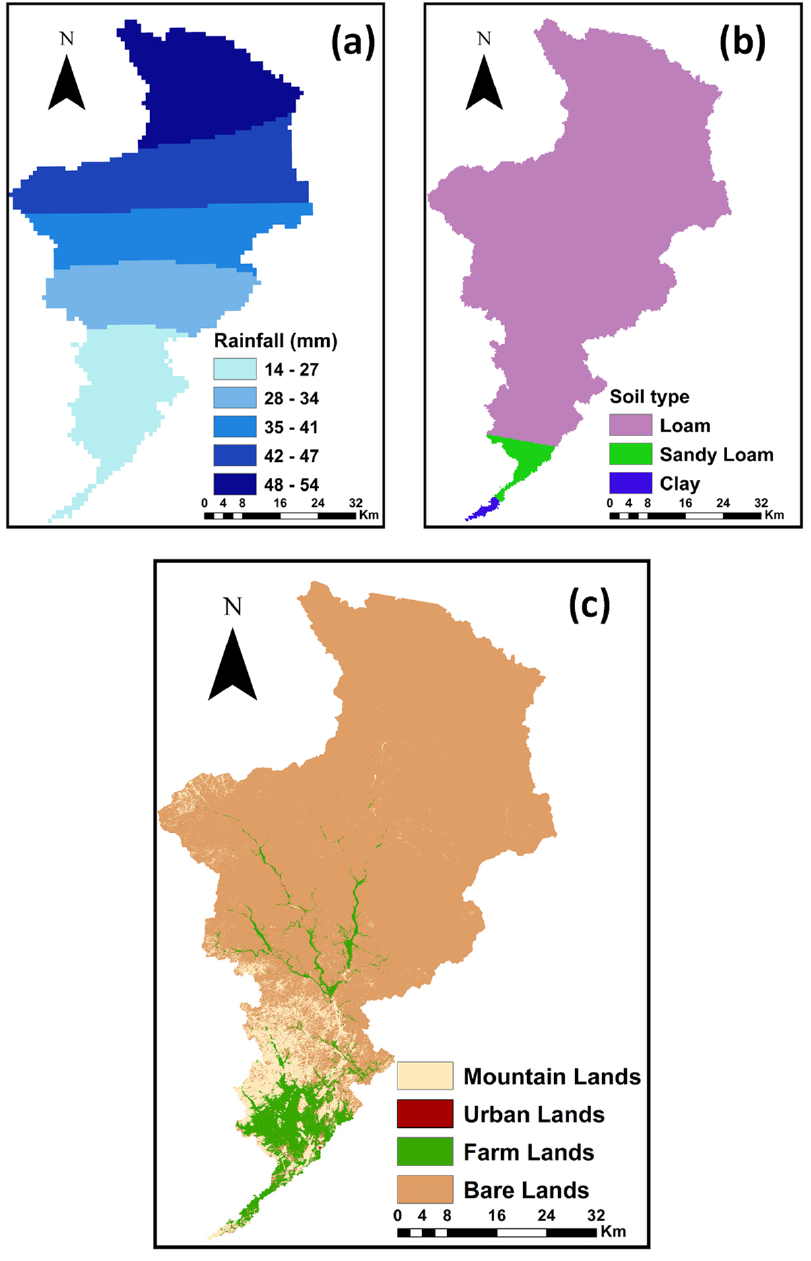
Figure 6. Flood hazard factors: ( a ) rainfall (average maximum daily values); ( b ) soil; ( c ) land use data.